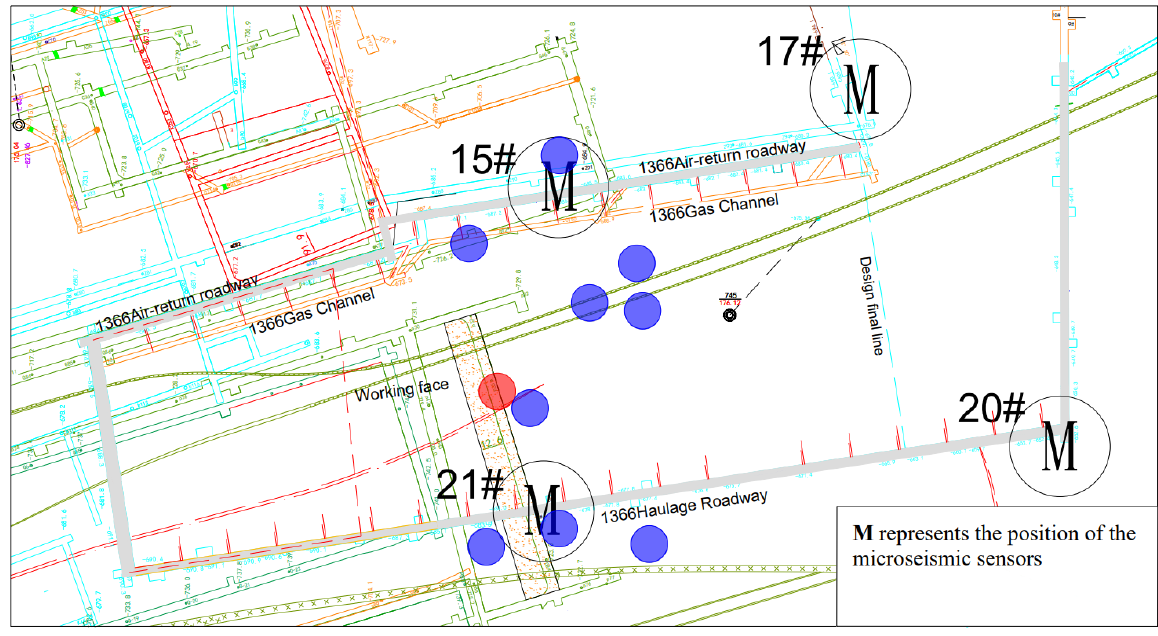
Figure 3. Distribution of microseismic events in 1366 working face.